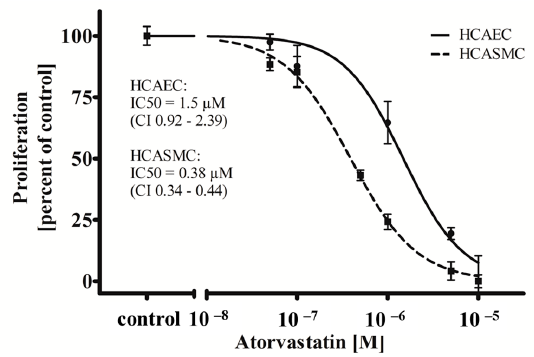
Figure 2. Atorvastatin (ATOR) acts cell type-specifically on human coronary artery vascular cells. HCAEC and HCASMC were treated for 48 h with the indicated range of concentrations of ATOR. Proliferation was determined after BrdU incorporation. Dots show mean ± SD of at least three separate experiments normalized to the respective control. IC 50 values and the respective 95% confidence interval (CI) are indicated.